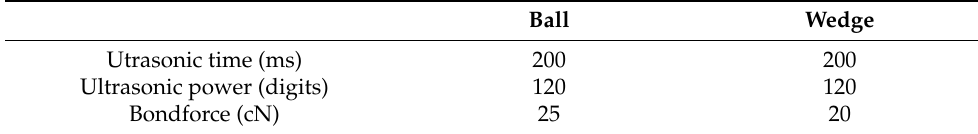
Table 2. Parameters for bonding.